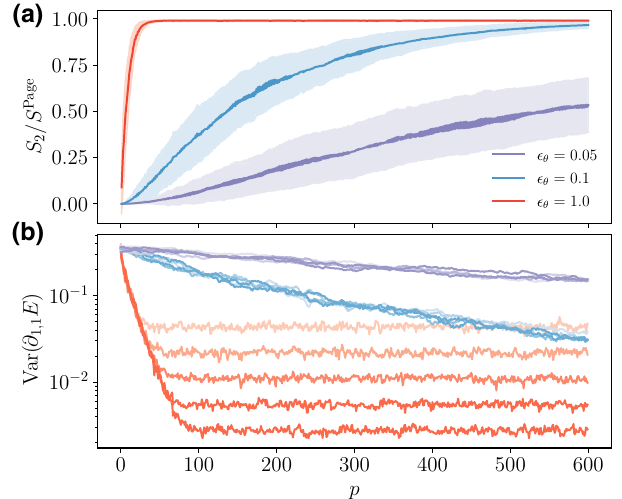
growth of the second Rényi entropy with the circuit depth p . The chosen region contains two qubits. (b) The encounter of BP in the variance of the gradient of the cost function is visible only for the case (cid:11) θ = 1, and it is preceded by the onset of a WBP. We use a system size of N = 16 for (a) and N = 8, . . . , 16 for (b), color intensity corresponds to system size, same as in Fig. 2. Data is averaged over 100 random instances, variance is for the σ z local term σ z 1 2